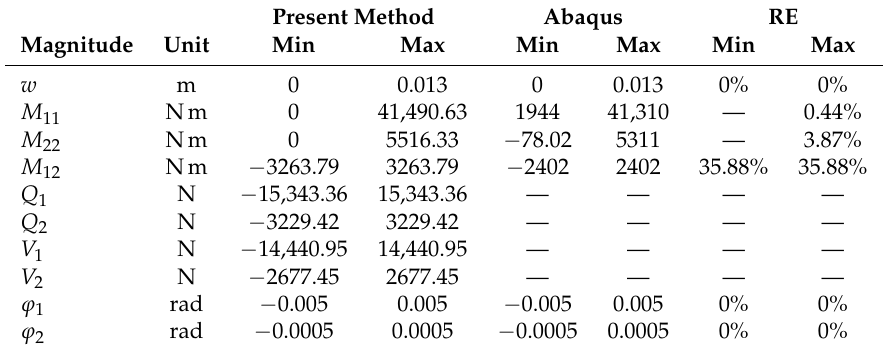
Table 1. Minimal and maximal values of kinematic and static magnitudes with their relative error (RE). Present Method